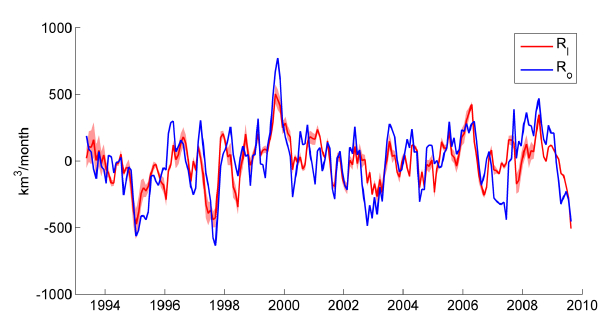
Fig. 8. Comparison of runoff computed from land–atmosphere ( R l ) Figure 8: Comparison of runoff computed from land-atmosphere (Rl) and ocean-atmosphere 3 (Ro) water budgets. The red shading represents discrepancies relative to the different 4 and ocean–atmosphere ( R o ) water budgets. The red shading repre- considered LSMs. 5 sents discrepancies relative to the different considered 6